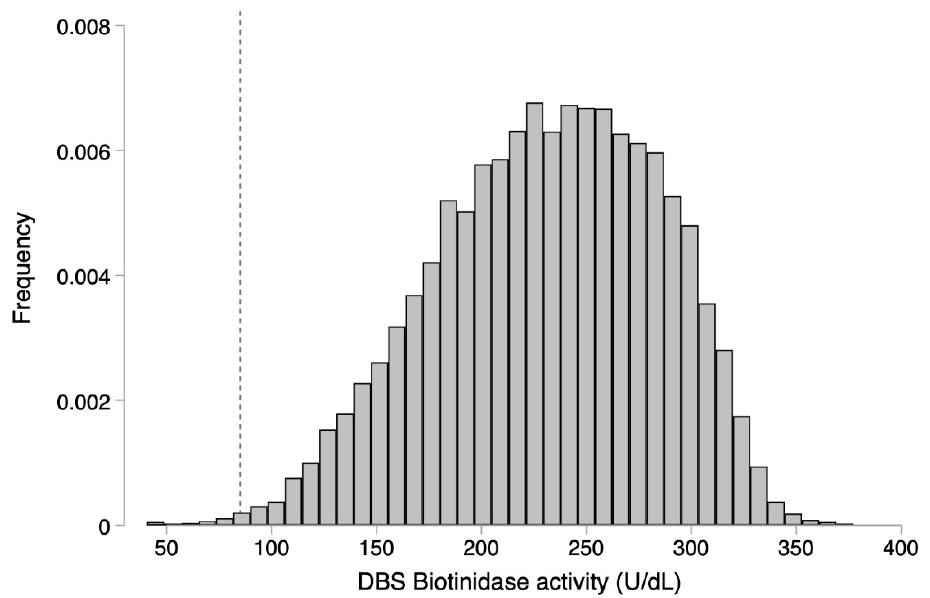
Figure 1. DBS biotinidase activity distribution in all the newborns screened. The dotted line represents the 85 U/dL cutoff.